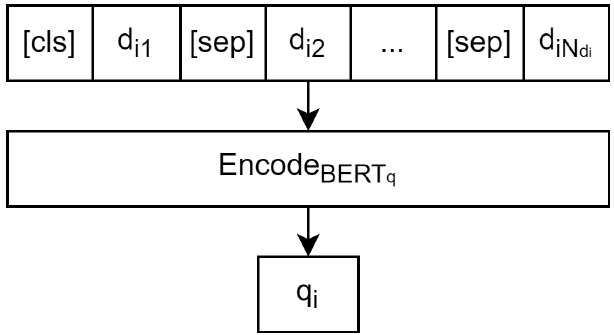
Figure 1. The scheme of the Encode BERT